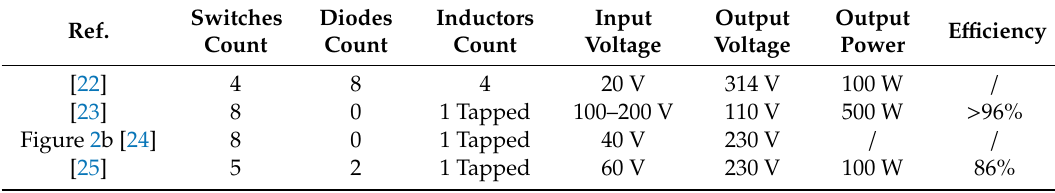
Table 1. Comparison of the main topologies of the existing single-stage, buck-boost inverters.